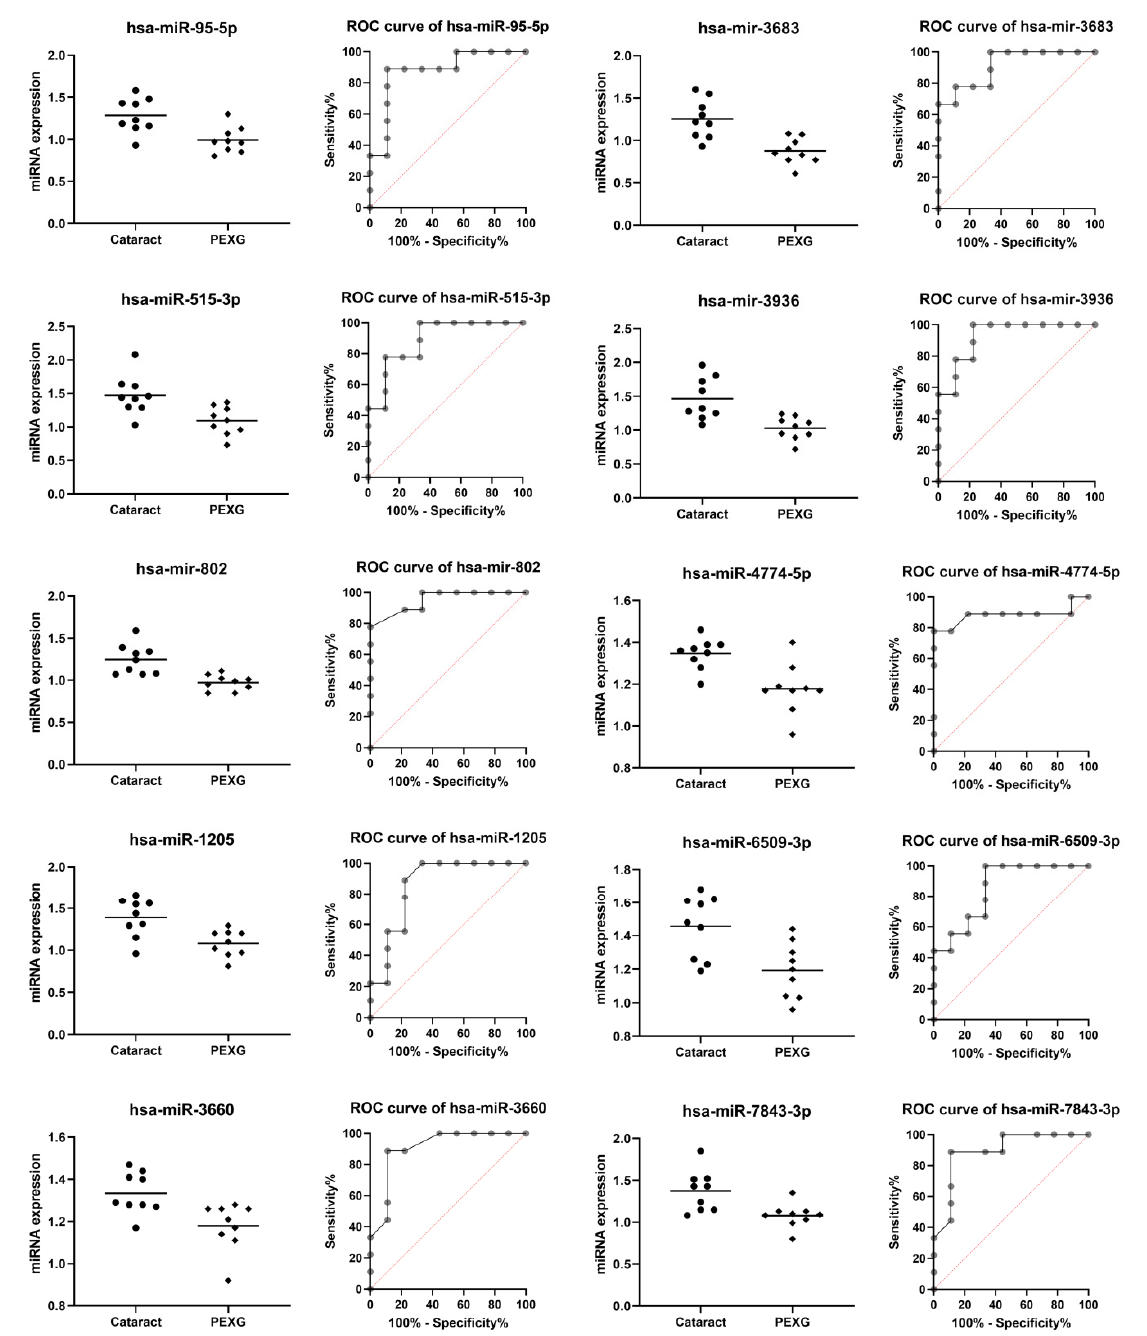
Figure 1. Lower miRNA expression in the PEXG group compared to the cataract group. Data are shown as mean [log2].